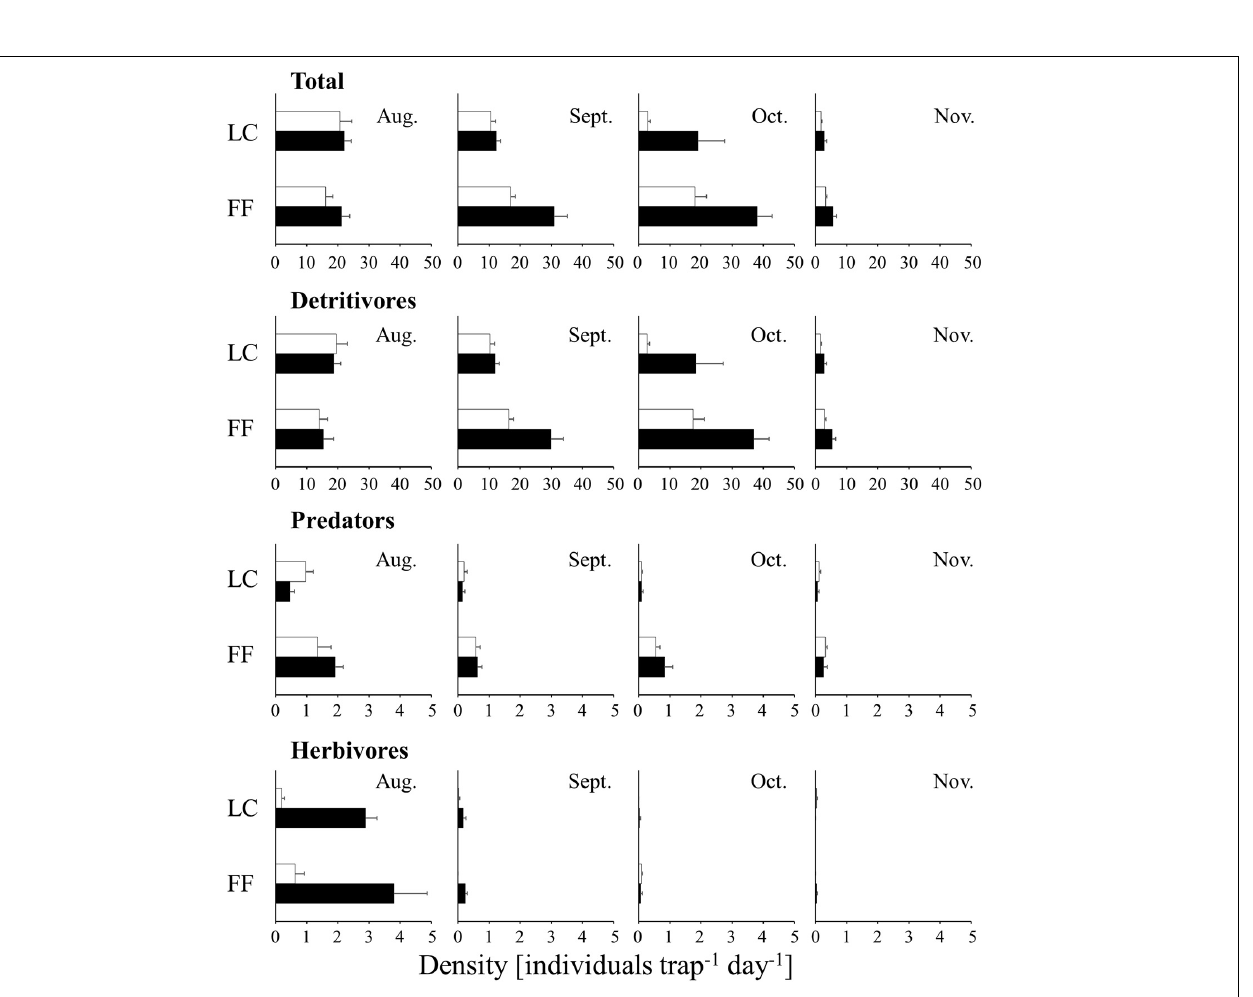
Frontiers in Forests and Global Change |